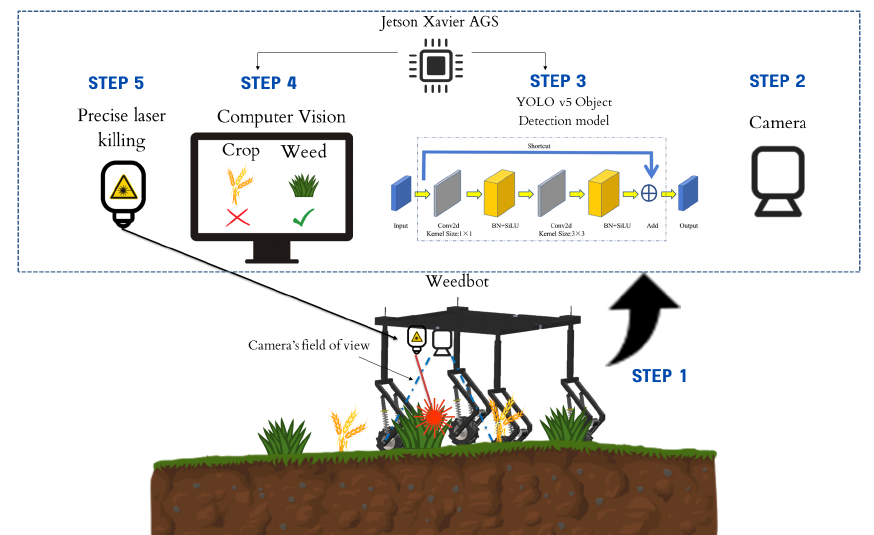
Figure 11. Functioning of a real-time, laser-based weed detection